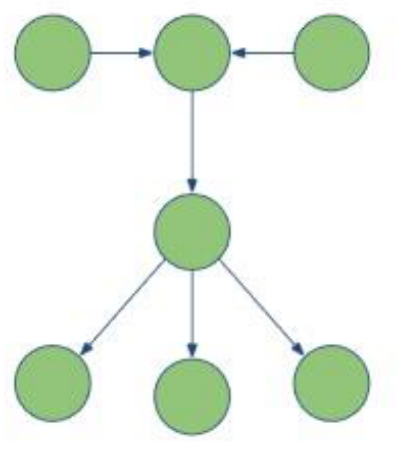
Figure 10. Visual representation of creation and adoption.